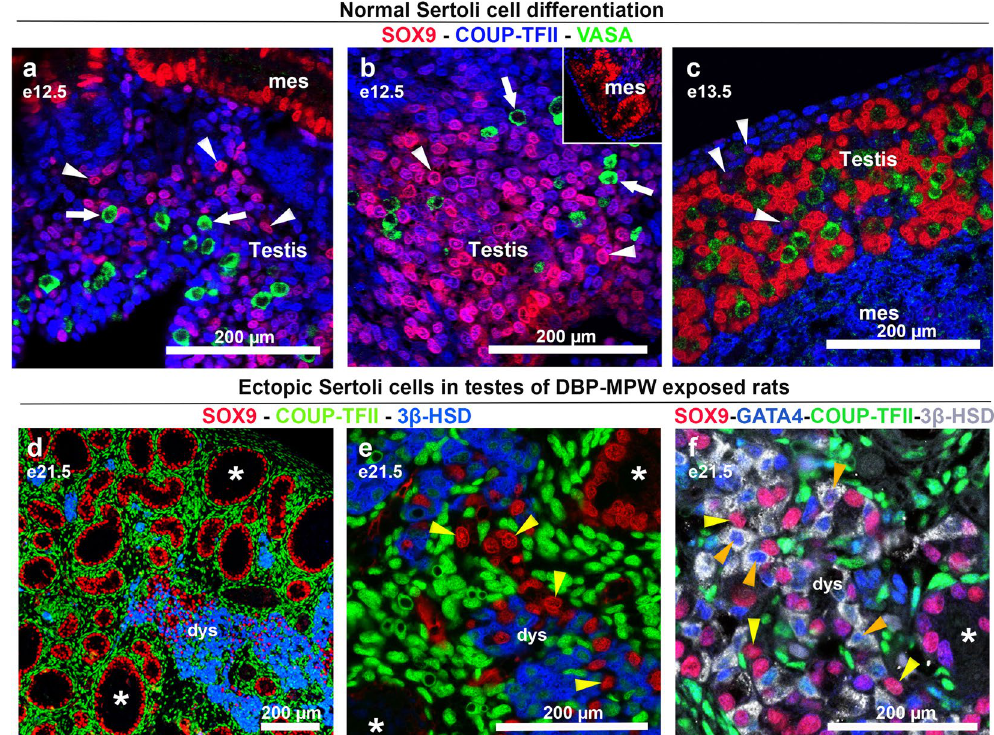
Figure 2. Protein expression pattern of ectopic Sertoli cells at e21.5 in the testes of DBP-MPW animals in comparison to that of Sertoli cells during normal differentiation at e12.5–e13.5. ( a – c ) Sections were triple immunostained for SOX9 (red, Sertoli cells), COUP-TFII (blue, mesenchymal cells) and VASA (green, germ cells) whereas ( d , e ) were immunostained for SOX9 (red, Sertoli cells), COUP-TFII (green, mesenchymal cells), and 3 β -HSD (blue, Leydig cells); Panel f was co-immunostained for SOX9 (red, Sertoli cells), GATA4 (blue, Leydig and Sertoli cells), COUP-TFII (green, mesenchymal cells) and 3 β -HSD (grey, Leydig cells). During normal testis development SOX9-immunopositive (Sertoli) cells differentiate from COUP-TFII- immunopositive mesenchymal cells at e12.5 ( a , b : white arrowheads) and when their differentiation is complete at e13.5, the Sertoli cells lose COUP-TFII expression ( c ); germ cells are VASA-immunopositive (green staining, highlighted by white arrows in a , b ). In contrast to the expression pattern during normal testis differentiation, the ectopic Sertoli cells (yellow arrowheads) that appear in late gestation in the testes of DBP-MPW animals never co-express COUP-TFII ( d , e ), nor Leydig cell (orange arrowheads) markers (3 β -HSD; f ). * Seminiferous cords; mes = mesonephros; dys = dysgenetic